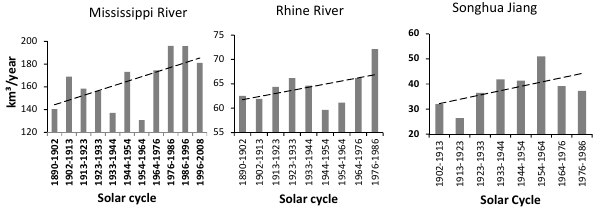
Figure 4. Rivers with positive discharge trends.